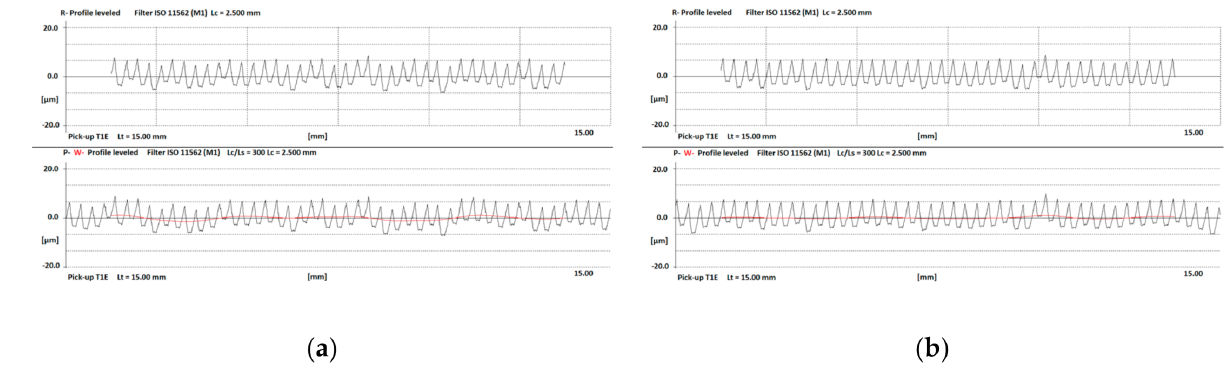
Figure 5. R, W, and P profiles of the sixth machined sample (L/D = 6; AISI 304): ( a ) section 1, ( b ) section 2.